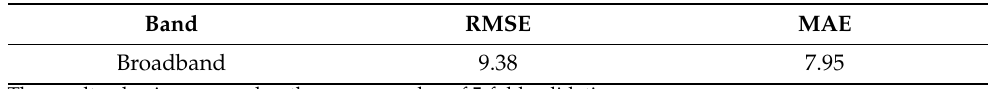
Table 6. BDI regression performance of image-based baseline model.